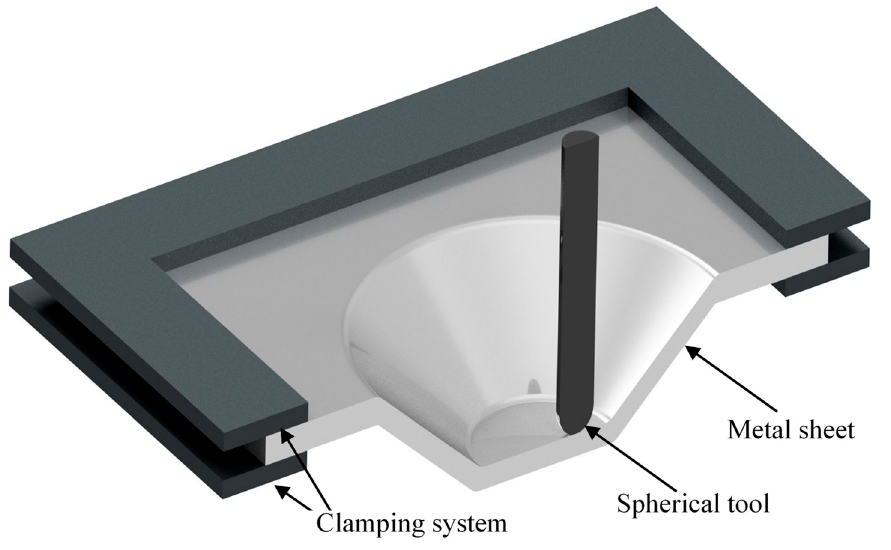
Figure 1. A schematic diagram of the SPIF system.